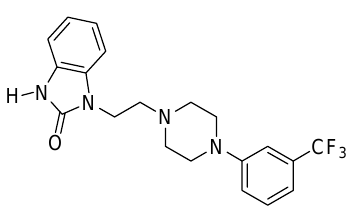
Figure 1. Chemical structure of flibanserin.